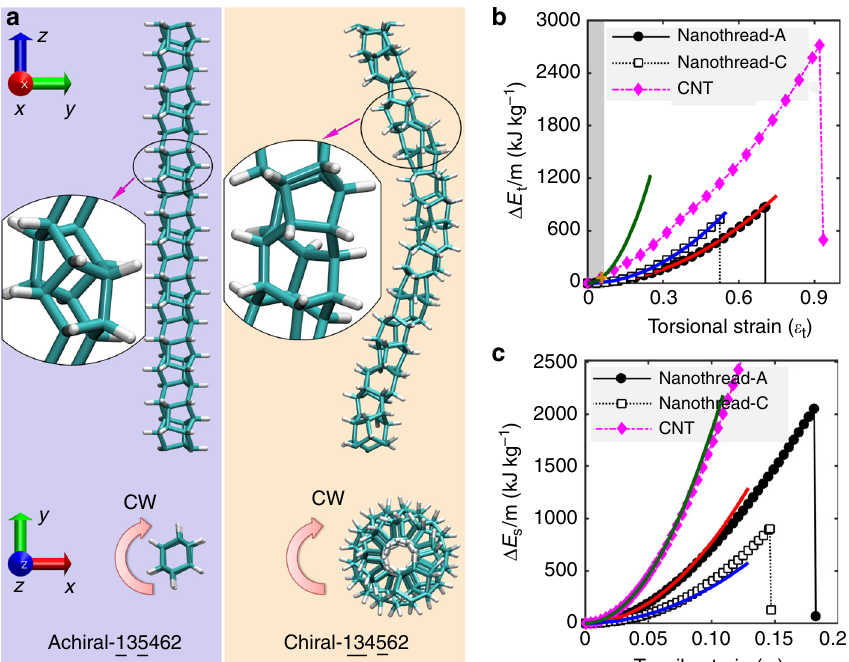
Fig. 1 Strain energy density of an individual nanothread and CNT from MD simulations. a Atomic con fi gurations of nanothread-A (left, 135462) and nanothread-C (right, 134562). The six integers (some underscored) represent the bonding topology in the structure. Upper panels are side views, and bottom panels are end-on views. CW refers to the clockwise torsion. b Torsional strain energy density vs. the dimensionless torsional strain. c Tensile strain energy density vs. the tensile strain. Solid lines in b , c are the corresponding fi tting curves based on Hooke ’ s law.